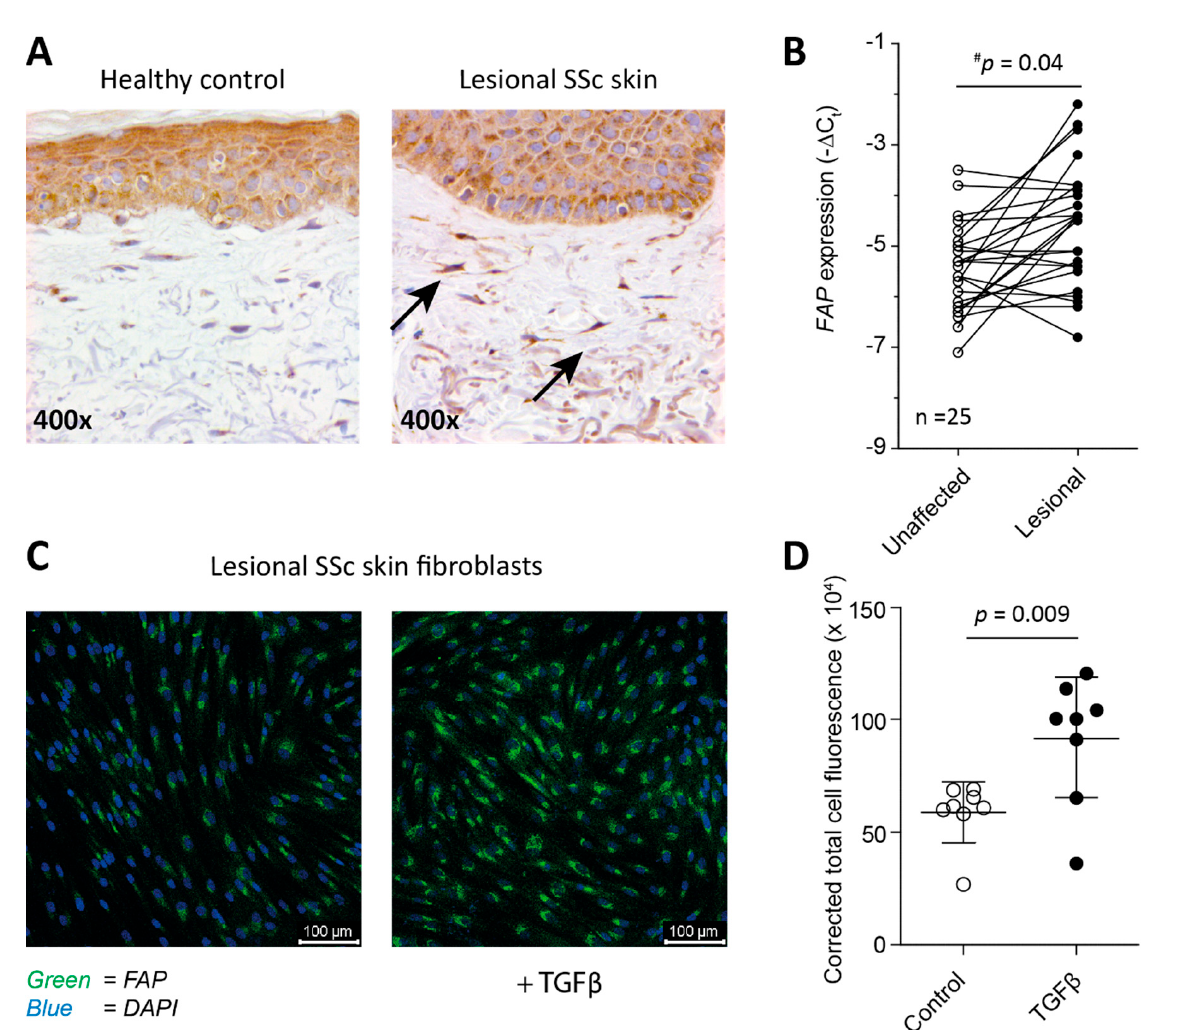
Figure 1. (Myo)Fibroblasts in lesional SSc skin express FAP. Skin biopsies stained for FAP using IHC show presence of FAP positive fibroblasts (black arrows) in lesional SSc skin ( A ). On average, FAP gene expression is significantly increased in lesional SSc skin compared to unaffected skin of the same patients as determined by a one-sided paired Students’ T-test. The reported # p value is a corrected p value, the uncorrected p value is 0.0013 ( B ). Primary fibroblasts obtained from lesional SSc skin express FAP in vitro as detected by immuno-fluorescence microscopy ( C ), and FAP expression is significantly increased by stimulation with 10 ng/mL TGF β for 5 days ( D ).